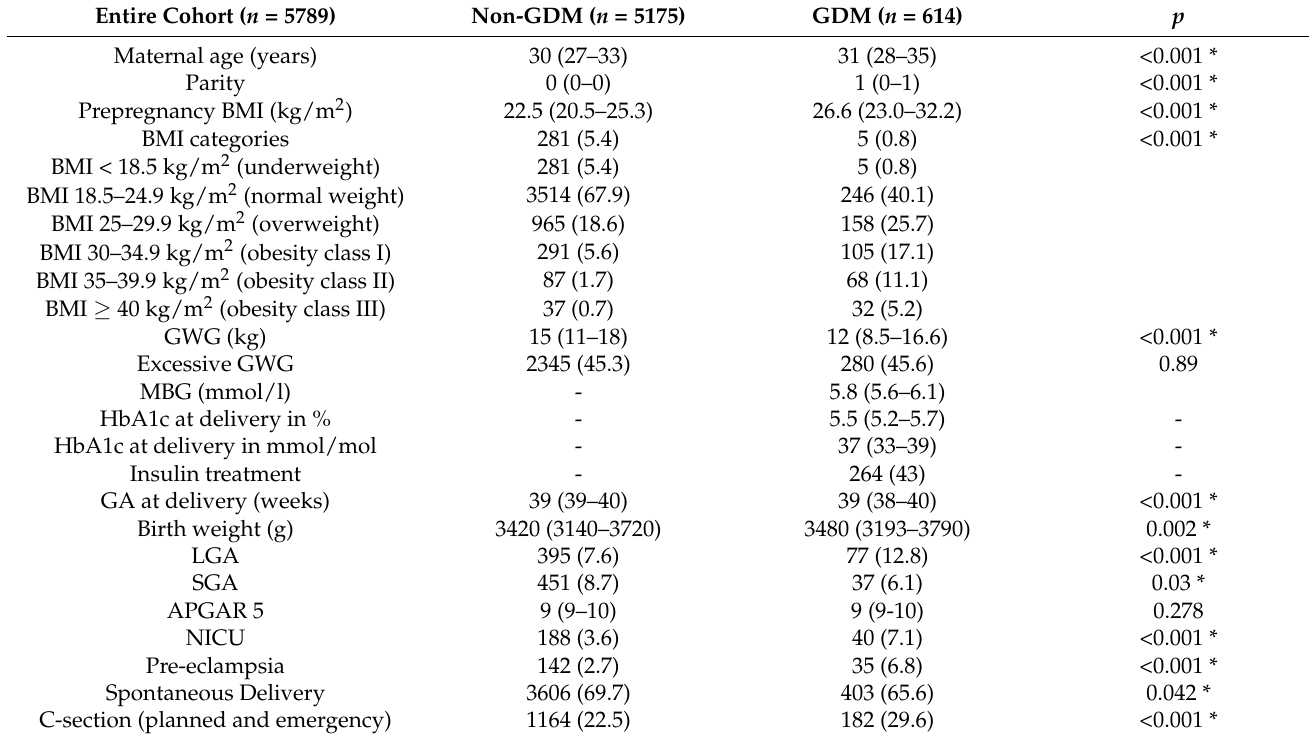
Table 1. Descriptive parameters of pregnancies with and without